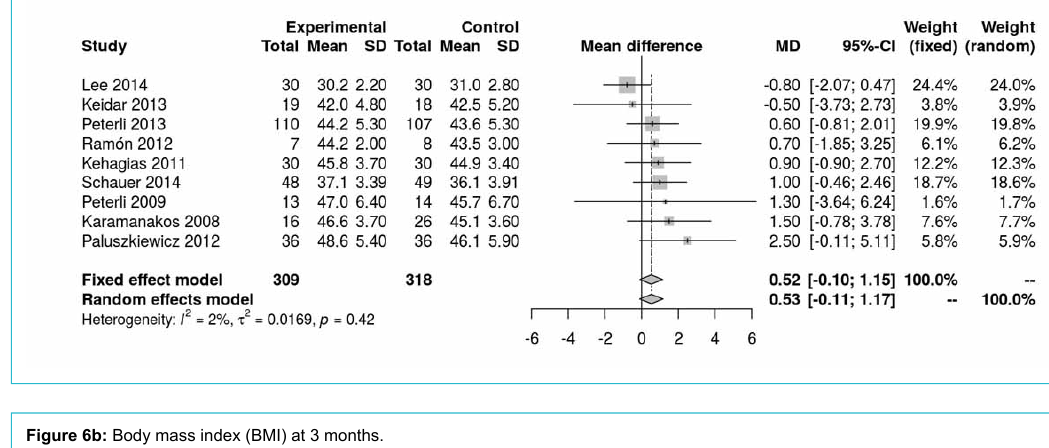
Figure 6b: Body mass index (BMI) at 3 months.